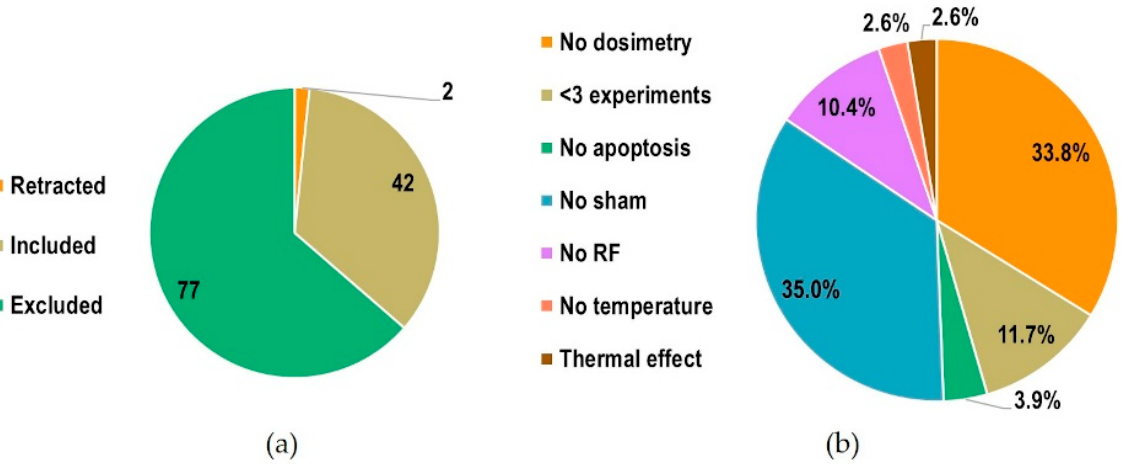
Figure 2. ( a ) Number of included, excluded and retracted studies; ( b ) motivations for exclusion with relative proportions.